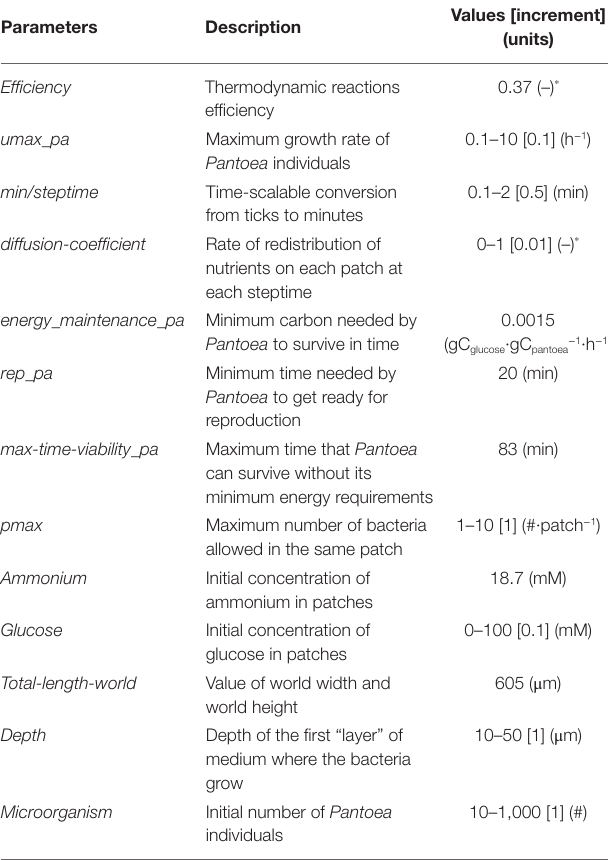
TABLE 1 | Parameters in the agent-based modeling